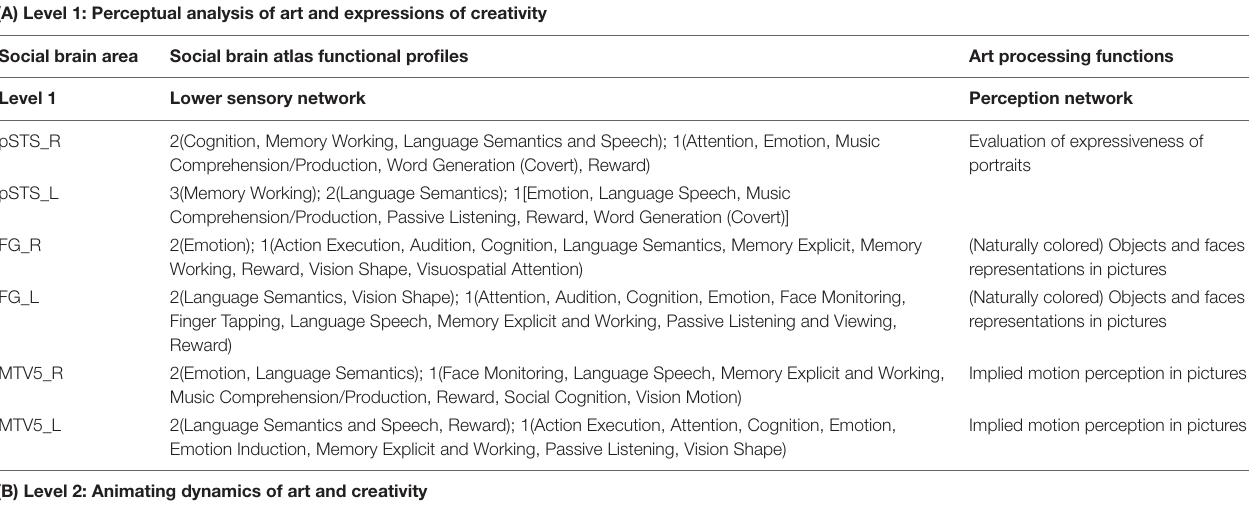
TABLE 1 | Summary of social and proposed art processing functions mediated by the social brain connectome. (A) Level 1: Perceptual analysis of art and expressions of creativity Social brain